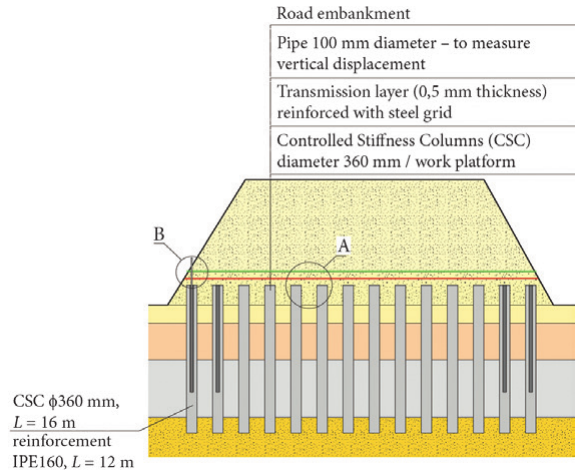
Fig. 2. Measurement scheme on cross-section of the